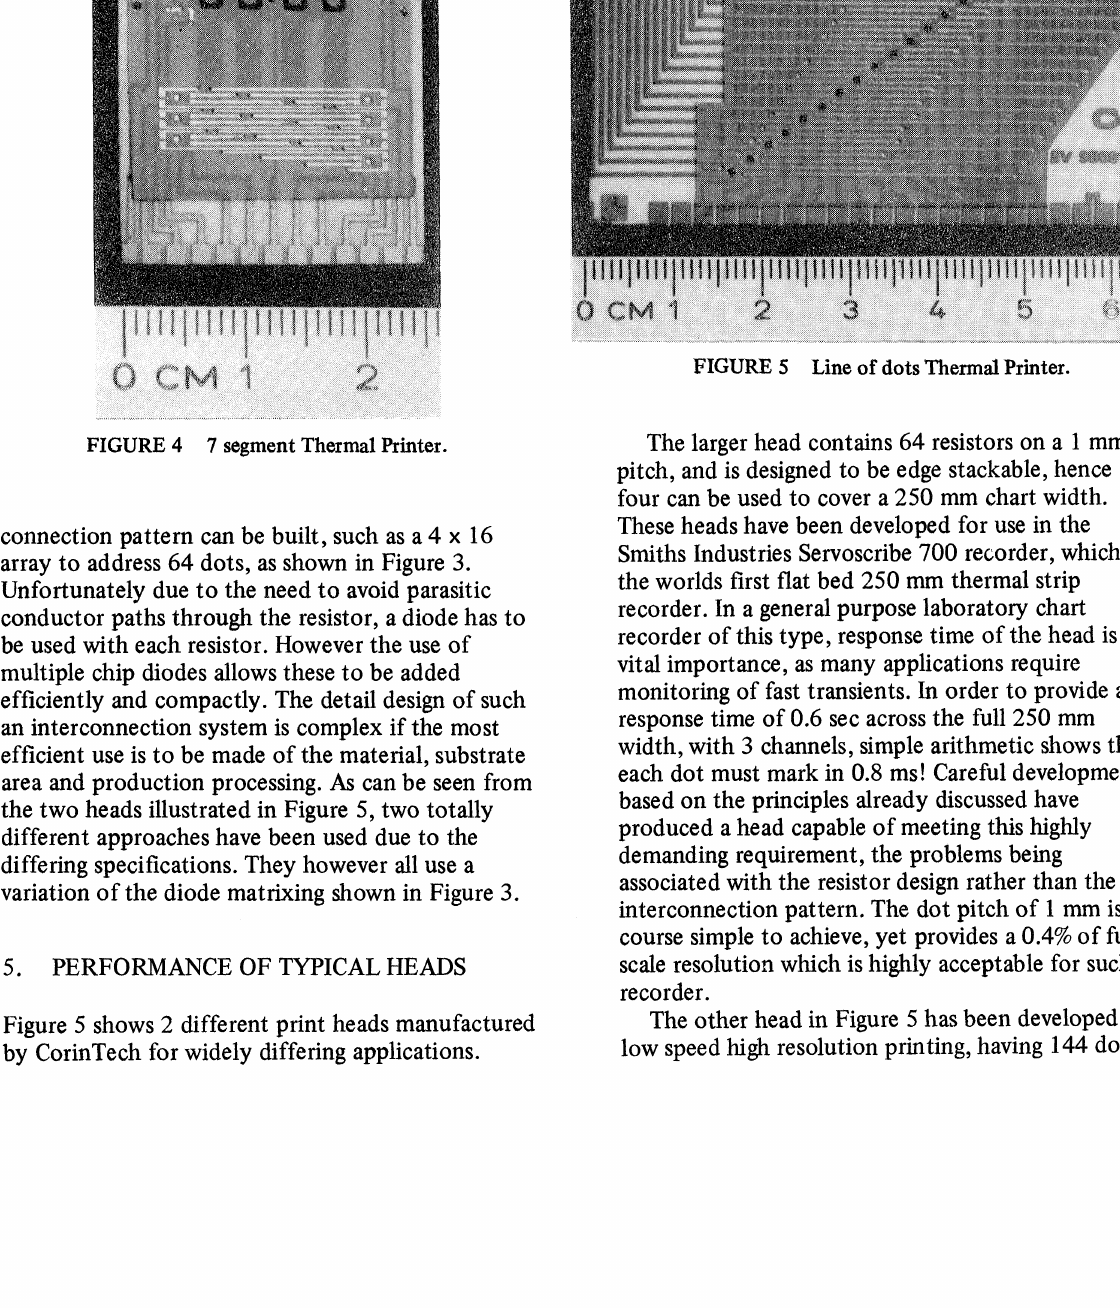
FIGURE 5 Line of dots Thermal Printer.